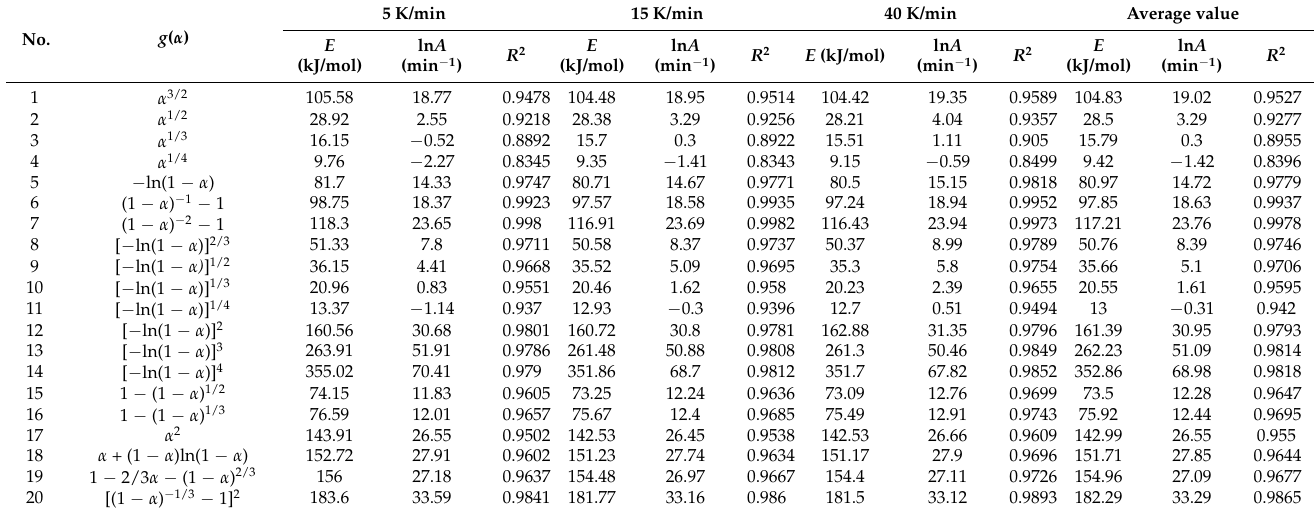
Table 5. E , ln A , and R 2 values of softwood computed via the CR approach with 18 kinetic models at different heating rates in region